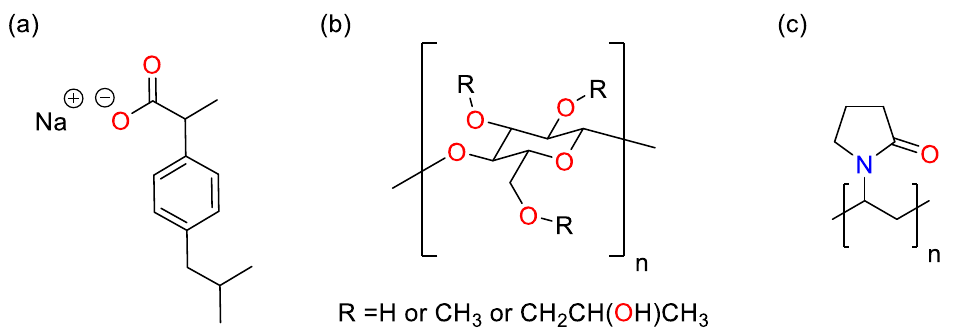
Figure 4. Structures of components used in the spray coating process. ( a ) Na Ibu, ( b ) HPMC, and ( c )